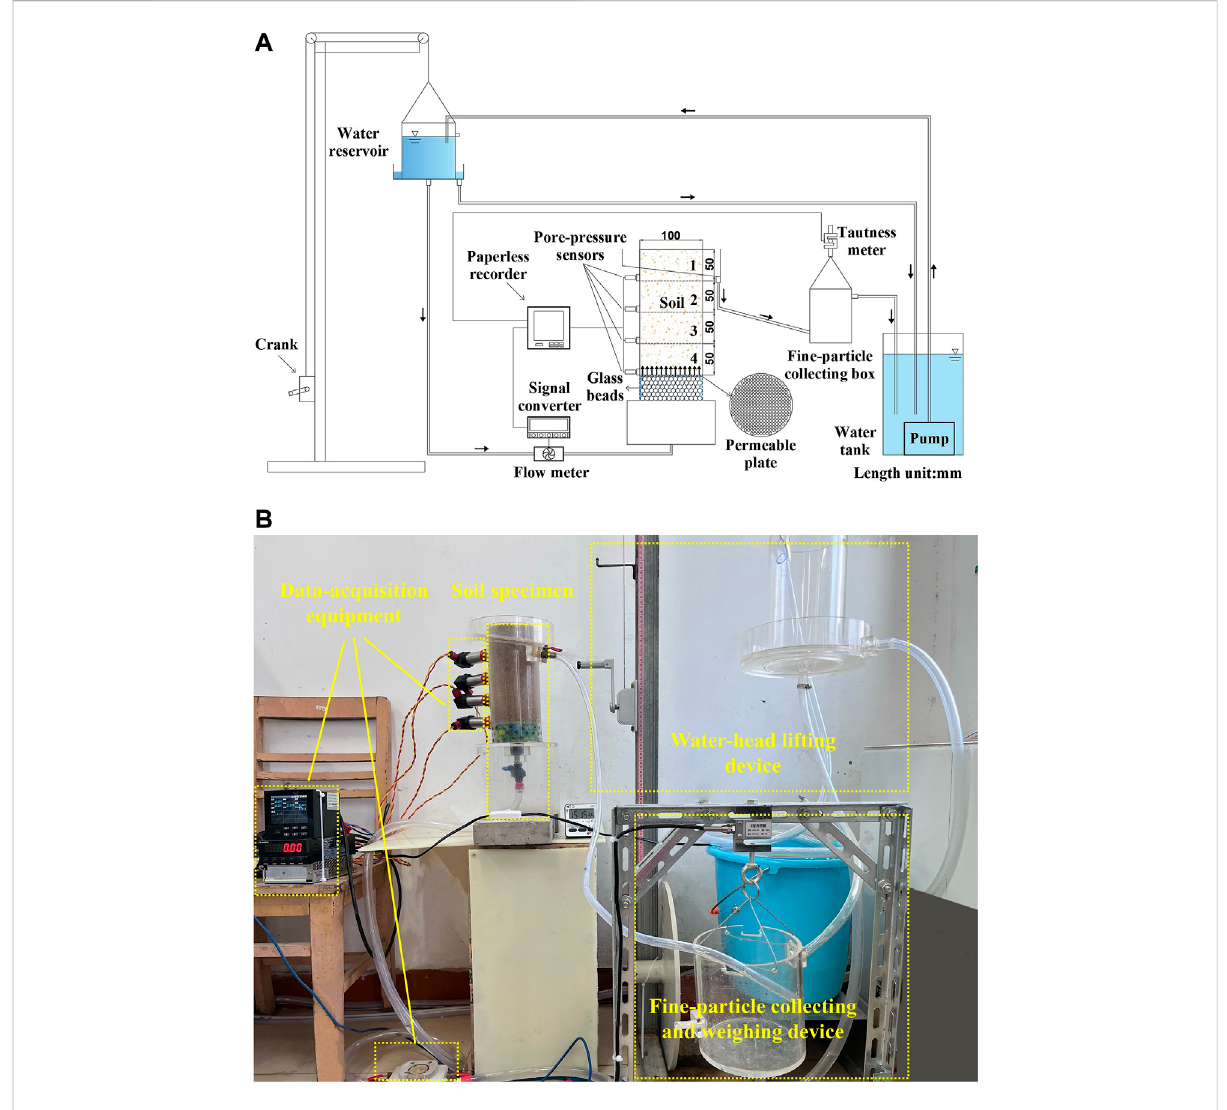
FIGURE 1 Experimental apparatus: (A) schematic; (B)